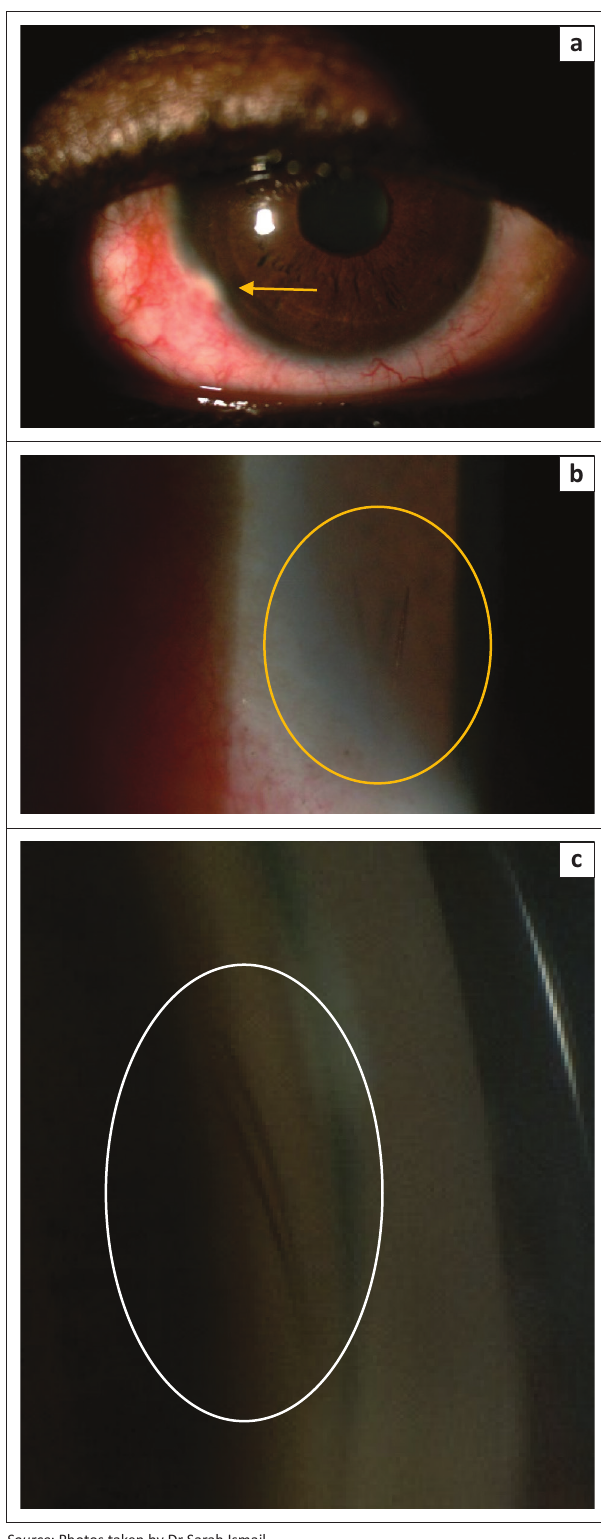
FIGURE 1: (a) Anterior segment photo showing the conjunctival injection and limbal inflammation (yellow arrow). (b) Anterior segment photo with sting projecting into the anterior chamber (yellow circle). (c) Gonioscopy with the sting apparatus visible in the angle (white circle).